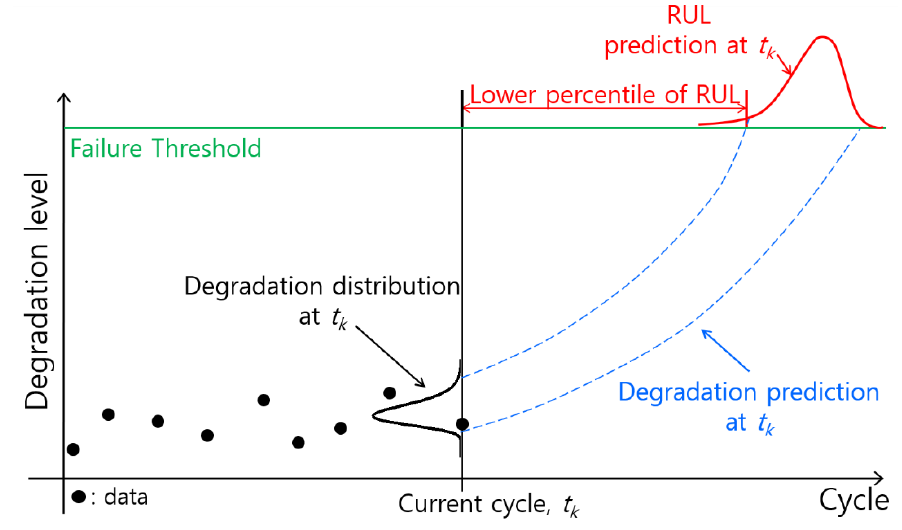
Figure 3. Illustration of prognostics results at the current cycle, t k.